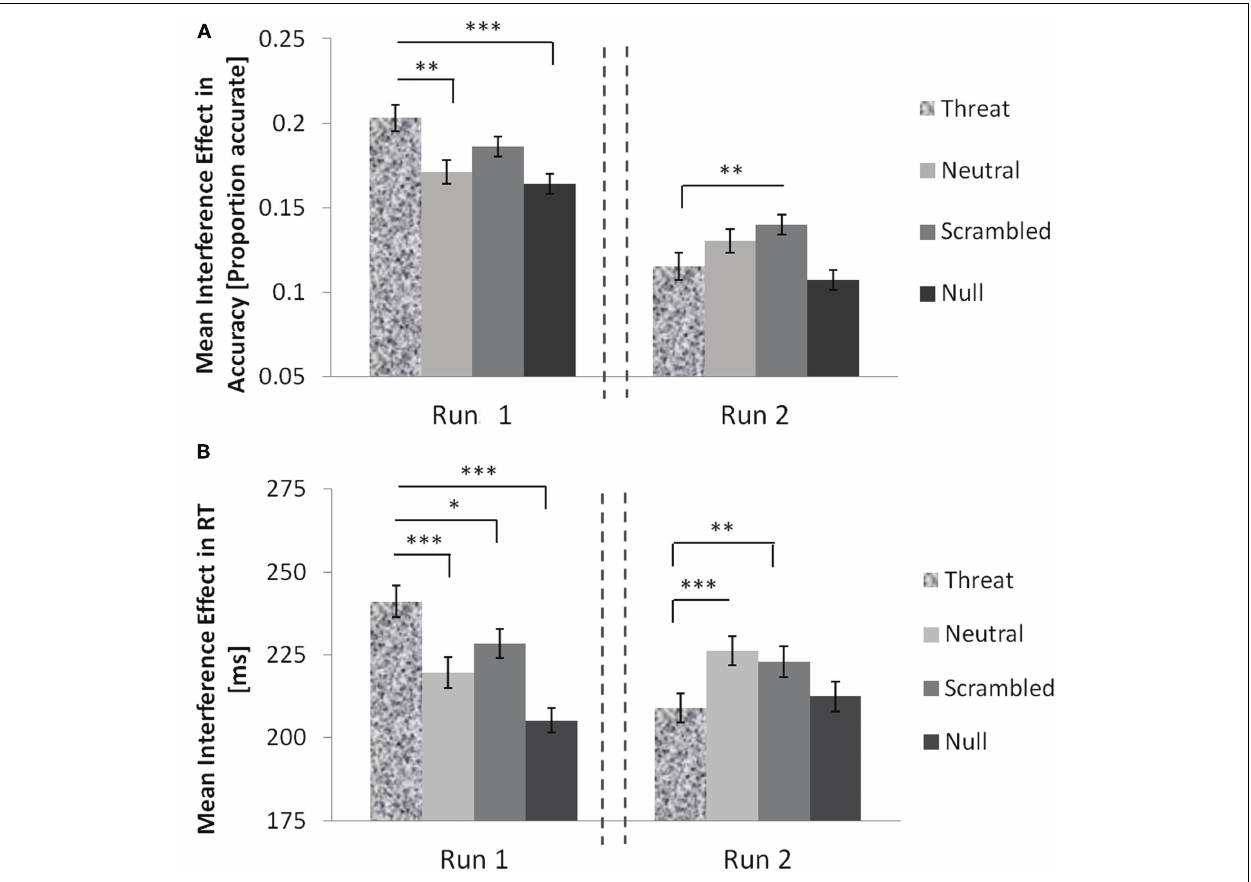
conditions in run 1 but these effects were abolished in run 2. Error bars show standard errors of the mean.The dashed lines denote an intermission. Significant two-tailed t -tests: * p < 0.05; ** p < 0.01; *** p <